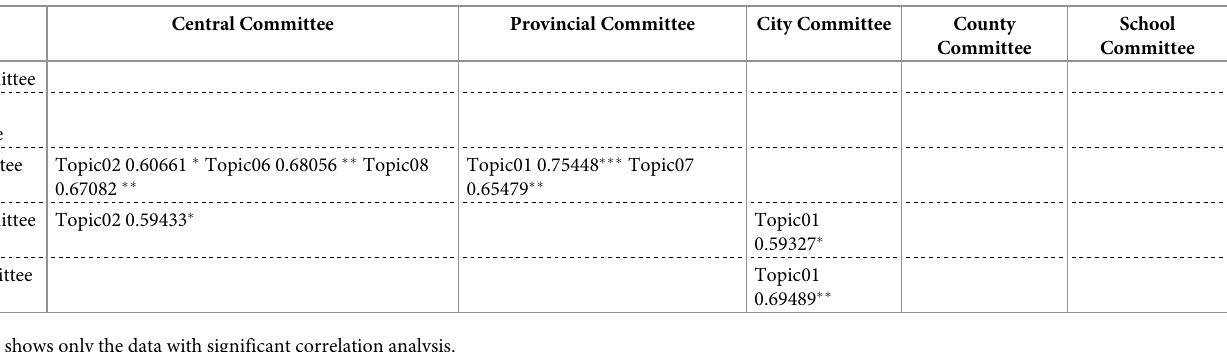
Table 8. Correlation analysis of news topics among committees.